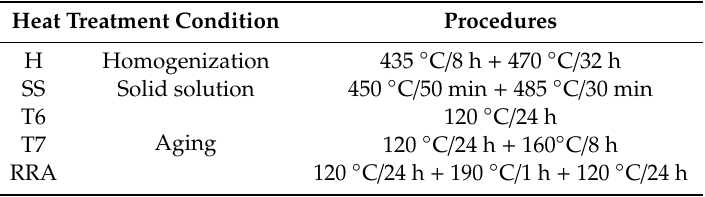
Table 2. Heat treatment procedure of experimental